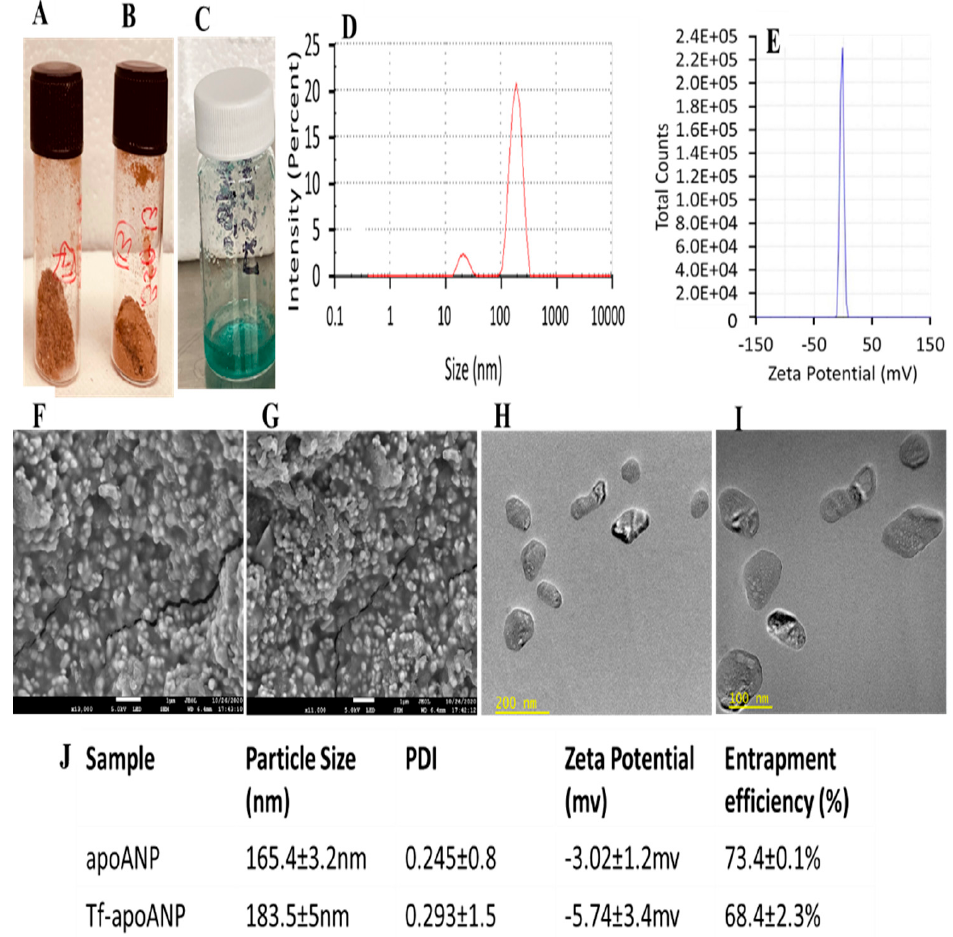
Figure 2. Characterization of apoANPs and tf-apoANPs. Freeze-dried samples of ( A ) apoANPs, ( B ) tf-apoANPs and ( C ) Cy5.5-conjugated tf-apoANPs. Particle sizes of ( D ) apoANPs and ( E ) tf- apoANPs. Representative SEM images of ( F ) apoANPs (magnification = 25,000×) and ( G ) tf- apoANPs (magnification = 30,000×). Representative TEM images of ( H ) apoANPs (magnification = 26,000×) and ( I ) tf-apoANPs (magnification = 26,000×). ( J ) Table listing the particle size, PDI, zeta potential, and entrapment efficiency values of apoANPs and tf-apoANPs (data expressed as means ± SD ( n = 3), statistical significance ( p < 0.05)). PDI: Polydispersity index. The zeta potential quantifies the degree of repulsive interaction between nanoparticles and depends on the concentrations of the polymer and the incorporated drug. Specifically, the zeta potential is calculated as the difference in electrical potential between the surfaces of the nanoparticles and the bulk-surrounding medium [57]. The zeta potential information is helpful in predicting the storage stability of colloidal dispersions [27]. In our study, the apoANPs and tf-apoANPs exhibited anionic charges of − 2.52± 1.2 mV and − 3.14 ± 3.4 mV, respectively. Albumin comprises free carboxyl and amine groups, both of which could be utilized for covalent modification. In general, albumin shows a negative zeta potential (high anionic) at physiological pH and saline levels. Further, negative albumin (nearly neutral) can also be obtained via surface modifications of the anionic groups [23]. We obtained the FTIR spectra of BSA, transferrin, apocynin, apoANPs, and tf- apoANPs (Figure 3). The FTIR spectra of BSA displayed several distinguishing peaks at 3317 cm –1 arising from amine groups (N-H stretching vibration); a peak in the amide bond at 1657 cm –1 was attributed to C=O stretching vibration (amide I band), with another attributed to mixed vibrations of N-H bending and C-N stretching (amide II band) at 1536 cm –1 [53].